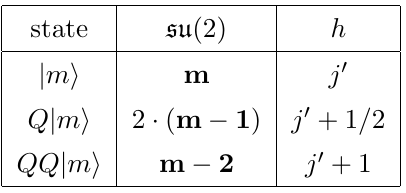
Table 8 . Chiral BPS multiplet. (Recall that m = 2 j 0 +